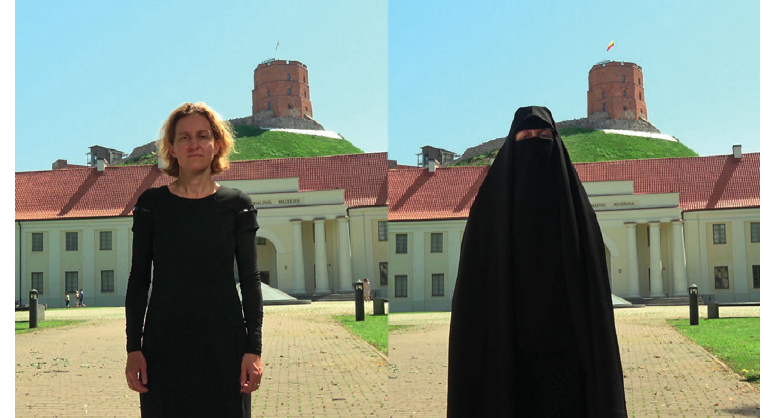
Figure 5. Sigita Maslauskaitė-Mažylienė. Partition: Niqab (2017)